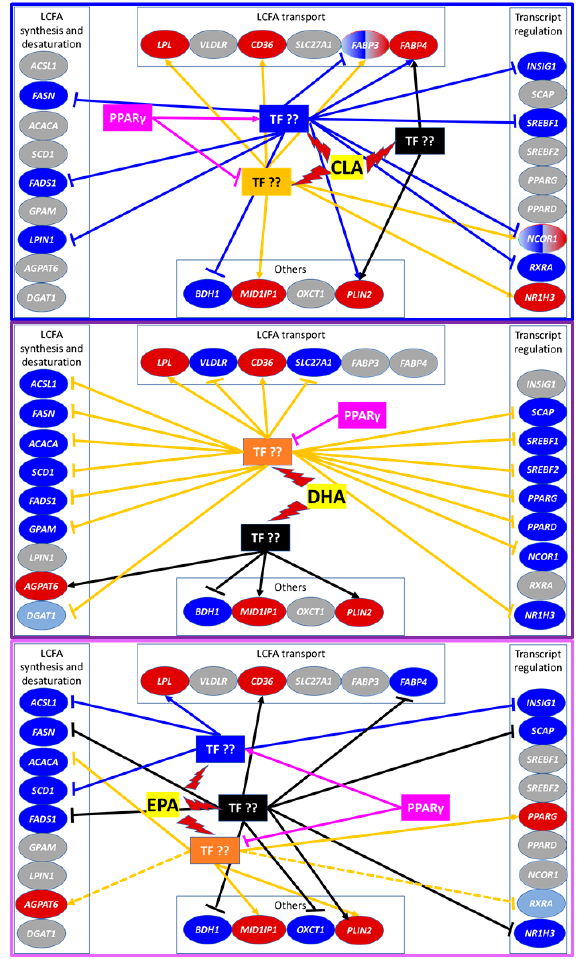
Figure 6. Schematic summary of the results from the present experiment for the response of expression of various genes in goat mammary epithelial cells to unsaturated fatty acids t10,c12 -CLA, DHA, and EPA. Genes are clustered in functional groups related to milk fat synthesis. As reported, it is also the possible interaction of LCFA with PPAR γ or other unidentified transcription factors (TF) to elicit the observed responses. Grey shade denotes no significant change, red shade denotes upregulation, and blue shade denotes downregulation relative to control. In connecting lines, arrow head denotes induction while flat head denotes inhibition. Lightning symbol denotes induction of TF by the LCFA. t10,c12 -CLA decreased the transcription of 9 genes via a TF (in blue) which activity was induced by activation of PPAR γ . The increase in transcription of 6 genes (i.e., LPL , CD36 , FABP3 , AGPAT6 , MID1IP1 , and NCOR1 ) by t10,c12 -CLA was via a TF (in orange) which activity was inhibited by PPAR γ . The transcription of only two of the measured genes ( FABP4 and PLIN2 ) was increased by t10,c12 -CLA acting upon an unknown TF (in black) that was independent from PPAR γ . DHA decreased the transcription of 16 genes and increased the transcription of 2 genes ( LPL and CD36 ) via a TF (in orange) which activity was inhibited by the activation of PPAR γ . Transcription of 3 genes ( AGPAT6 , MID1IP1 , and PLIN2 ) was upregulated and transcription of BDH was downregulated by DHA via a TF that was independent from PPAR γ (in black). EPA decreased the transcription of 12 genes but none directly via PPAR γ . However, the transcription of AGPAT6 and PPARG was upregulated and transcription of ACACA , RXRA, MID1IP1 , and PLIN2 was downregulated by EPA via a TF which activity was inhibited by PPAR γ (in orange). The transcription of ACSL1, SCD1, and INSIG1 was downregulated and the transcription of LPL was upregulated by EPA through one or more TF that were dependent from an activation of PPAR γ (in blue). Transcription of 9 genes was decreased or increased by EPA via one of more TF (in black) that were independent from PPAR γ .